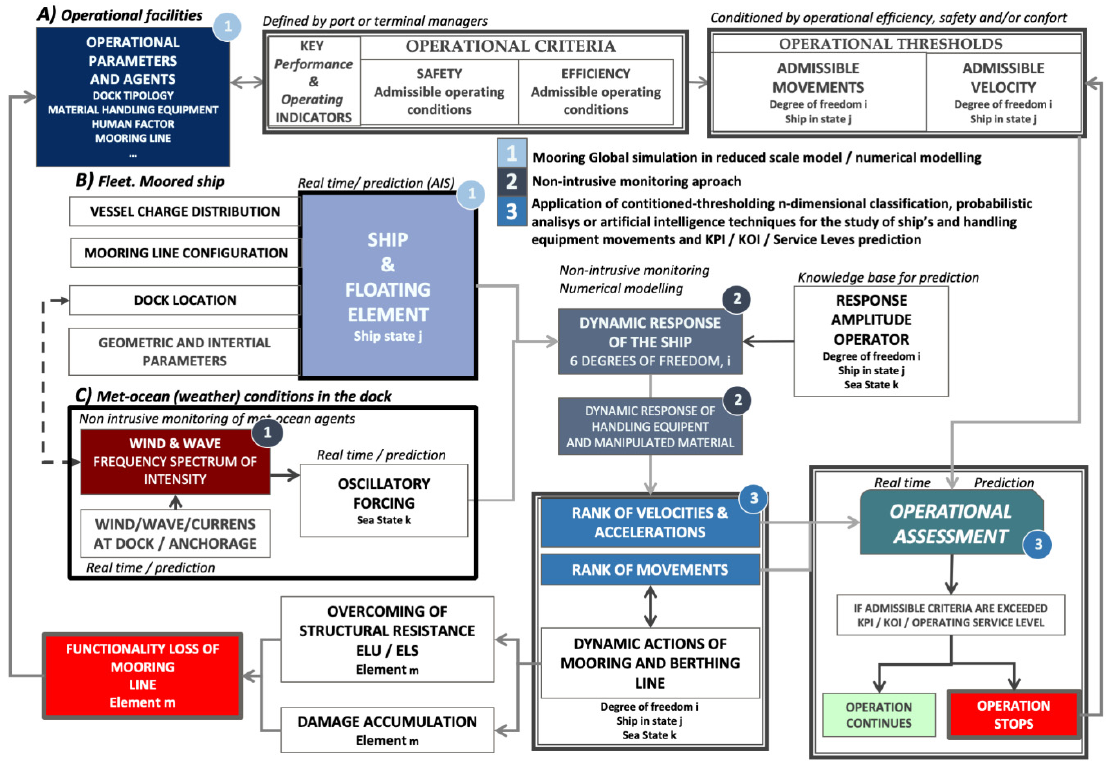
Figure 12. Summary of the present and future strategy for assessing operability on berthed ships proposed by the authors. Own elaboration.